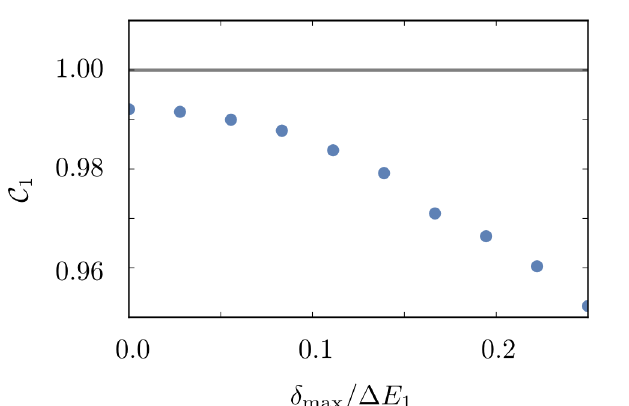
= 3, in presence y . max